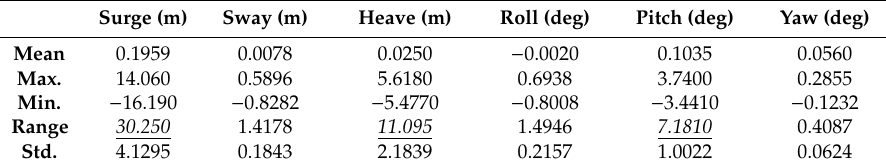
Table 8. 6-DOF motion statistics of WindFloat-type platform under a storm condition.